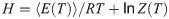
Heat capacity (left) and thermodynamic structural entropy (right) for a
thermoswitch, or RNA thermometer, from the ROSE 3 family RF02523 from the Rfam 11.0 database [40], with EMBL accession code AEAZ01000032.1/24229-24162.Lighter curves in the background correspond to the heat capacity (left) and thermodynamic structural entropy (right) of random RNAs having the same dinucleotides, obtained by the implementation in [43] of the Altschul-Erikson dinucleotide shuffle algorithm [42]. Since structural entropy H=〈E(T)〉/RT+lnZ(T) and heat capacity C(T)=∂∂T〈E(T)〉, the derivative of entropy H with respect to temperature closely follows the curve of the heat capacity (data not shown). Heat capacity computed using Vienna RNA Package RNAheat [10], and entropy computed by method DP.